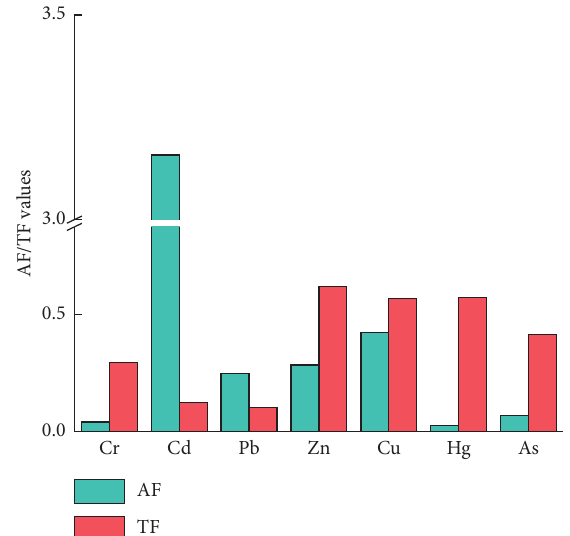
Figure 5: AF and TF values of heavy metals at the harvesting period of